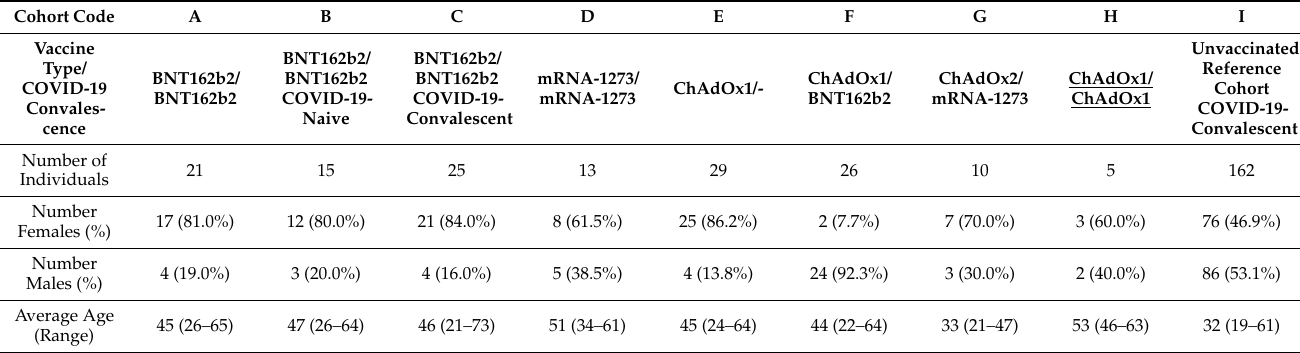
Table 1. Age and gender characteristics of different vaccination cohorts and a reference cohort of unvaccinated COVID-19- convalescent individuals. For comparison of serological immune responses after first vaccination, cohorts A, D, and E were compared with cohort I. For comparison of serological immune responses in COVID-19-naive and COVID-19-convalescent vaccinated individuals, cohort B was compared with cohort C. For comparison of serological immune responses after second vaccination, cohorts A, D, and H were used to represent homologous vaccination schemes, and cohorts F and G to represent heterologous vaccination